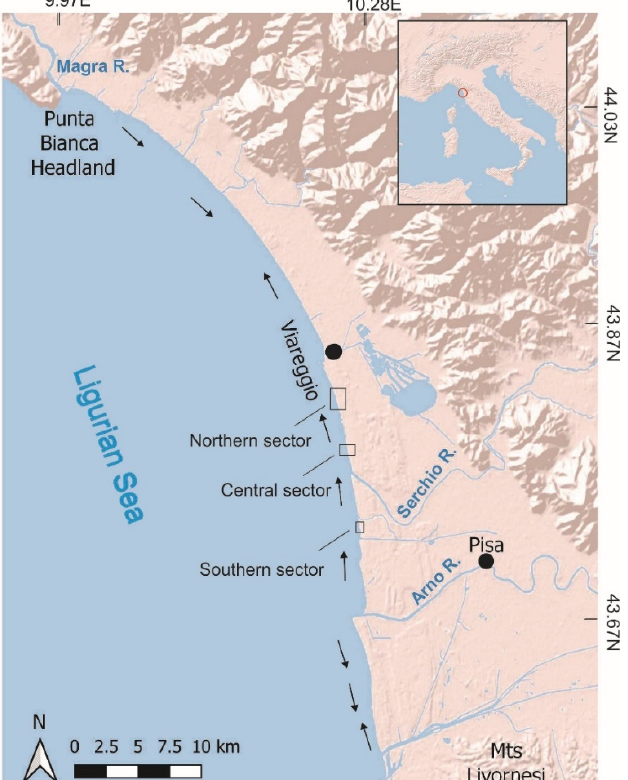
Figure 1. Geographical sketch of the Northern Tuscany littoral cell. The black arrows represent the direction of the littoral drift.